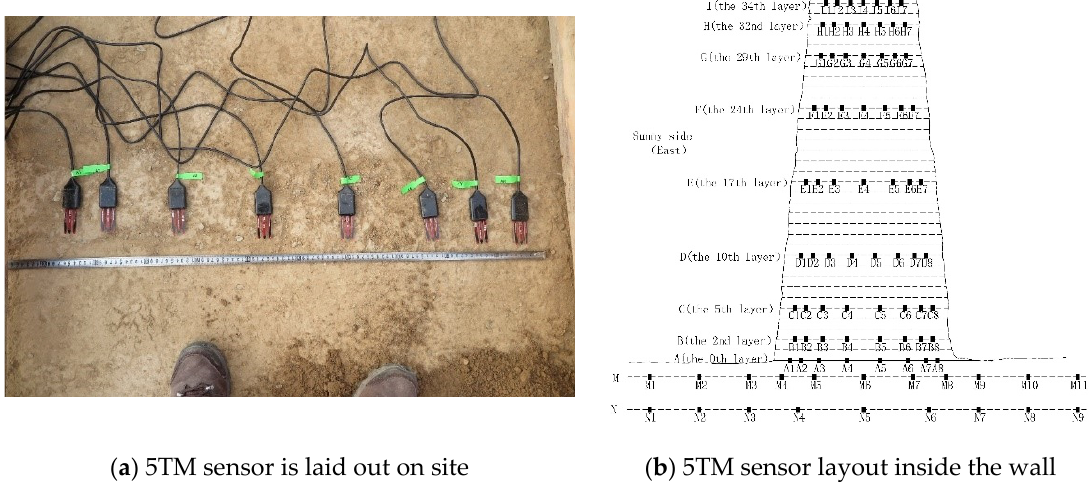
Figure 5. 5TM soil moisture temperature sensor